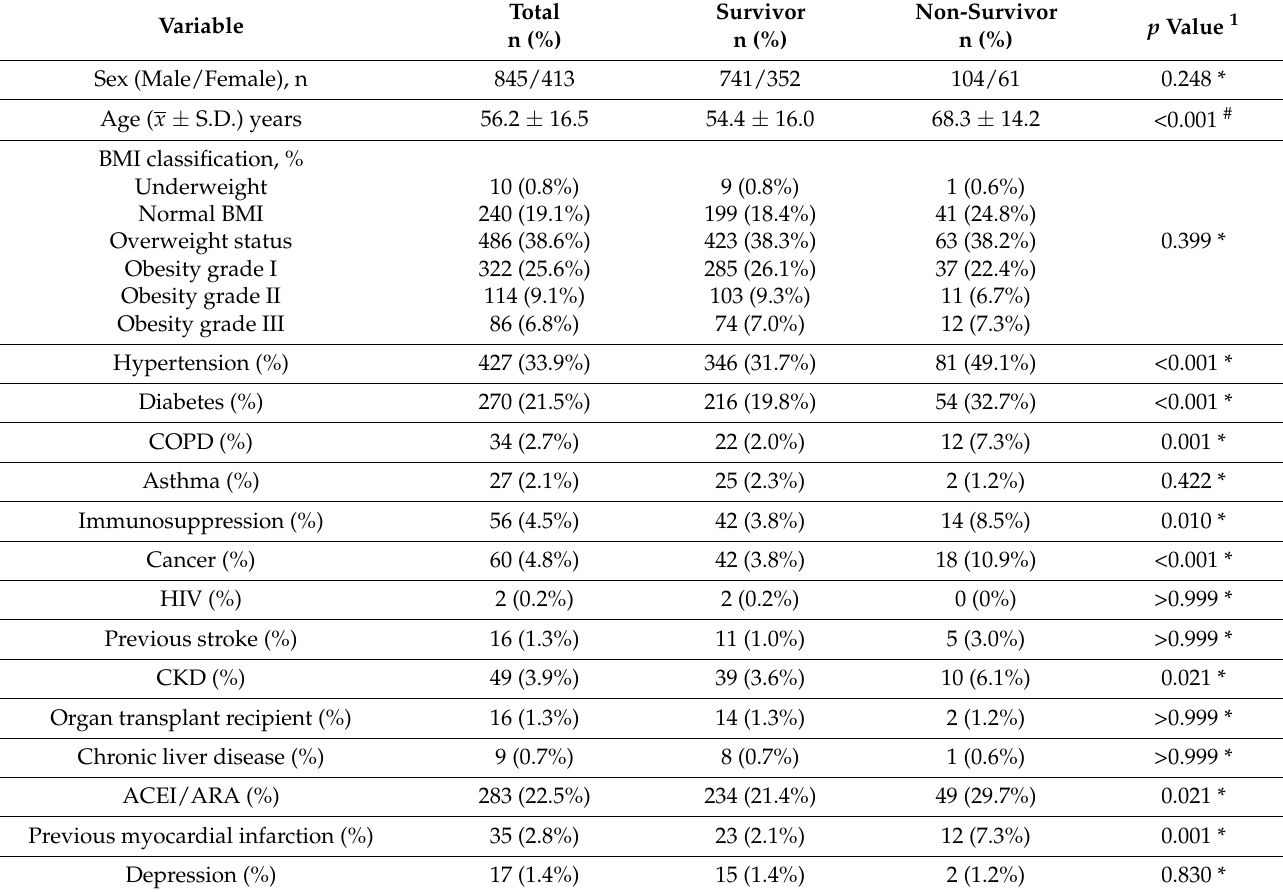
Table 1. Comparisons of the demographic and clinical characteristics of survivors and non-survivors at